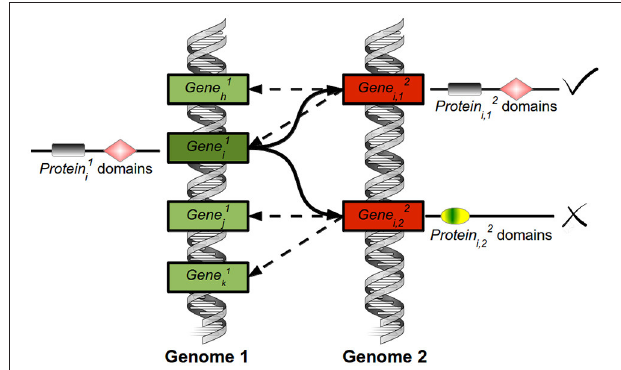
FIGURE 1 | Explicative diagram of the Multiple Bidirectional Best Hits tool. For the Protein 1 i encoded by the Gene 1 i from the first species (deep green), the algorithm selects the genes (red) encoding the N proteins that exhibit the highest sequence similarity ( protein 2 i , 1 , protein 2 i , 2 ,...protein 2 i , n ) . In this study, N was set to 20. These 20 proteins are called initial best hits. The same process is carried out for species 2. For each initial hit from species 2, the N genes (red) coding for proteins showing the highest sequence similarity are selected. Then, the initial best hits of the genes (green) coding for protein 1 i from species 1 are filtered. Only those genes coding for proteins that exhibit protein 1 i in their initial best hits are kept (marked by a √ symbol). Thus, bidirectionality